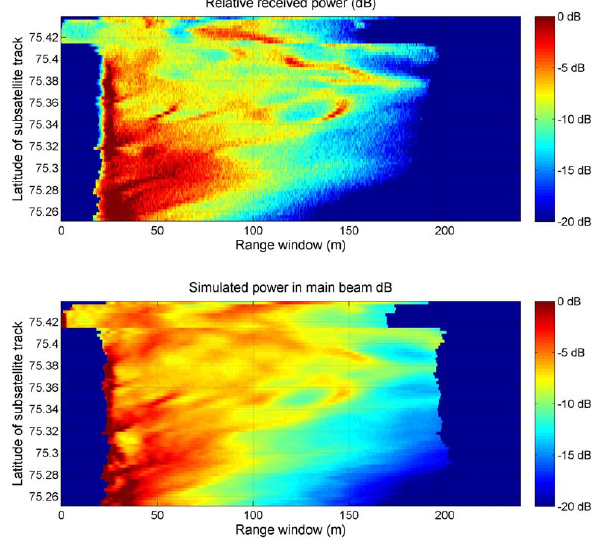
Fig. 10. Comparison of the relative received power (upper image) Figure 10. Comparison of the relative received power (upper image) with the simulated power with the simulated power for the main beam (lower image) for the for the main beam (lower image) for the Feb 23 descending pass data. In both cases the 23 February descending pass data. In both cases the dynamic range dynamic range from blue to red is 20 dB and in each case the dB scale is with respect to the from blue to red is 20dB and in each case the dB scale is with maximum value. The simulation is based on the footprint size, a near-nadir backscatter model respect to the maximum value. The simulation is based on the foot- and the two-way antenna gain pattern given by Eqn. 6. print size, a near-nadir backscatter model and the two-way antenna gain pattern given by Eq.